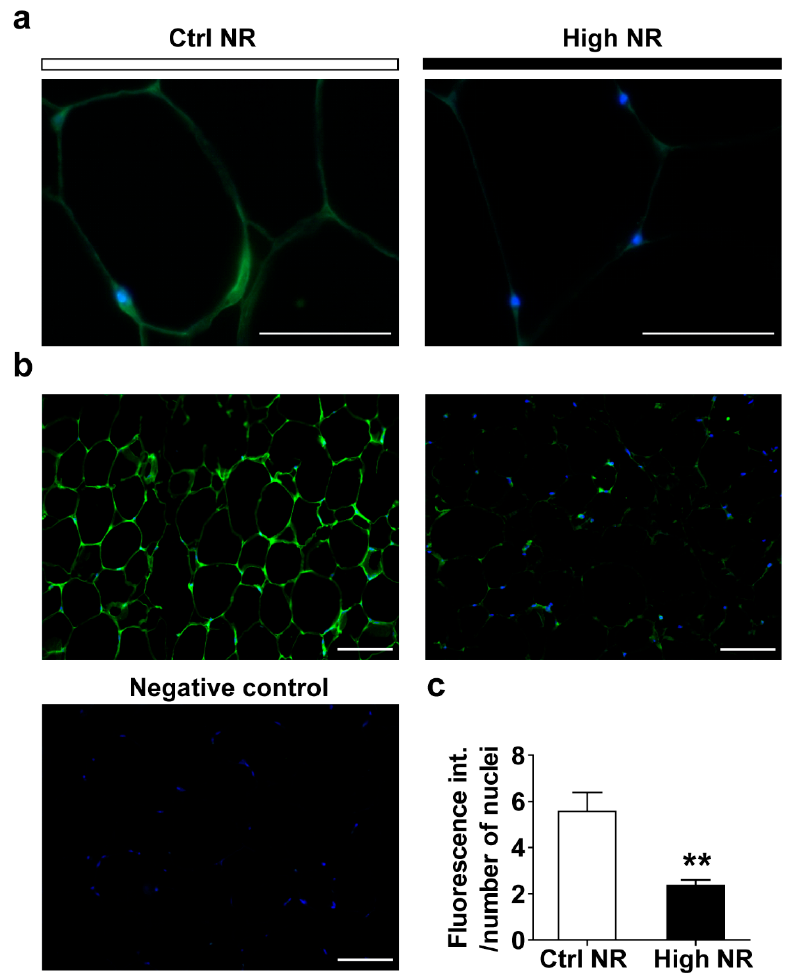
Figure4. HighNRresultsinlowerglucosetransportertype4(GLUT4)expressionineWAT.Representative Figure 4. High NR results in lower glucose transporter type 4 (GLUT4) expression in eWAT. pictures of GLUT4 expression at 100 × magnification ( a ): Control NR, left; high NR, right. Representative Representative pictures of GLUT4 expression at 100× magnification ( a ): Control NR, left; high NR, pictures of GLUT4 expression at 20 × magnification ( b ): Control NR, left; high NR, right. Negative control right. Representative pictures of GLUT4 expression at 20× magnification ( b ): Control NR, left; high NR, right. Negative control from control NR animal, left bottom. Green staining represents GLUT4, fromcontrolNRanimal, leftbottom. GreenstainingrepresentsGLUT4, bluedotsarenuclei. Quantification blue dots are nuclei. Quantification of GLUT4 fluorescence intensity, normalized by the number of of GLUT4 fluorescence intensity, normalized by the number of the nuclei (C, n = 15 pictures at 20 × the nuclei (C, n = 15 pictures at 20× magnification per animal, six animals per treatment). Scale bar magnification per animal, six animals per treatment). Scale bar represents 50 µ m. Data are analyzed represents 50 µm. Data are analyzed using Mann–Whitney test and presented as mean ± SEM. ** p < using Mann–Whitney test and presented as mean ± SEM. ** p < 0.01.